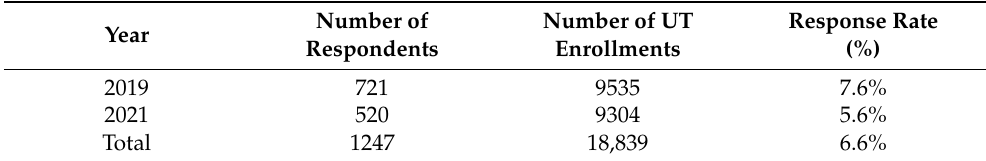
Table 1. Response rates.